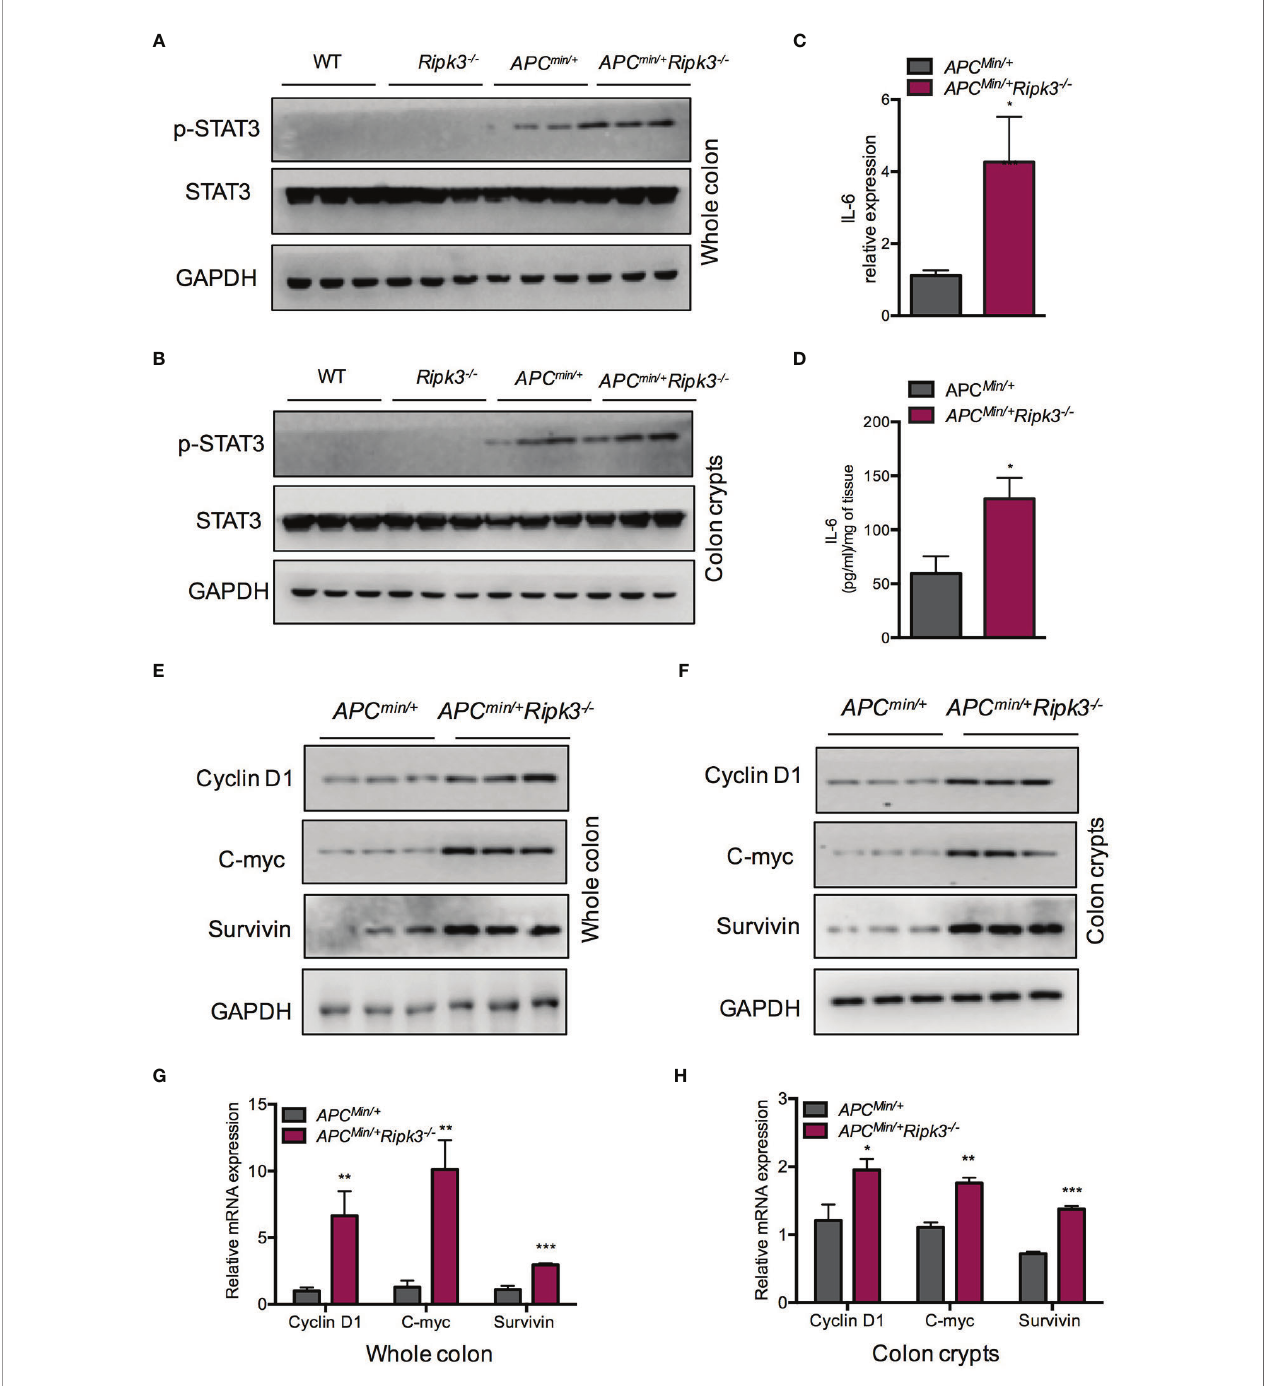
FIGURE 3 | Loss of RIPK3 activates STAT3 signals in Apc min/+ mice. (A) The expression of pSTAT3 in 6-week-old Apc min/+ and Apc min/+ Ripk3 -/- intestinal tumors. (B) The levels of pSTAT3 in Apc min/+ and Apc min/+ Ripk3 -/- colonic crypts. (C) Quantitative mRNA expression of IL-6 in Apc min/+ and Apc min/+ Ripk3 -/- intestinal tumors. (D) The protein levels of IL-6 in Apc min/+ and Apc min/+ Ripk3 -/- intestinal tumors as determined by ELISA. (E) The expression of STAT3 target genes in Apc min/+ and Apc min/+ Ripk3 -/- intestinal tumors. (F) The expression of STAT3 target genes in Apc min/+ and Apc min/+ Ripk3 -/- colonic crypts. (G, H) Quantitative mRNA expression of STAT3 target genes in Apc min/+ and Apc min/+ Ripk3 -/- intestinal tumors and colonic crypts. * p < 0.05, ** p < 0.01, *** p < 0.001 versus Apc min/+